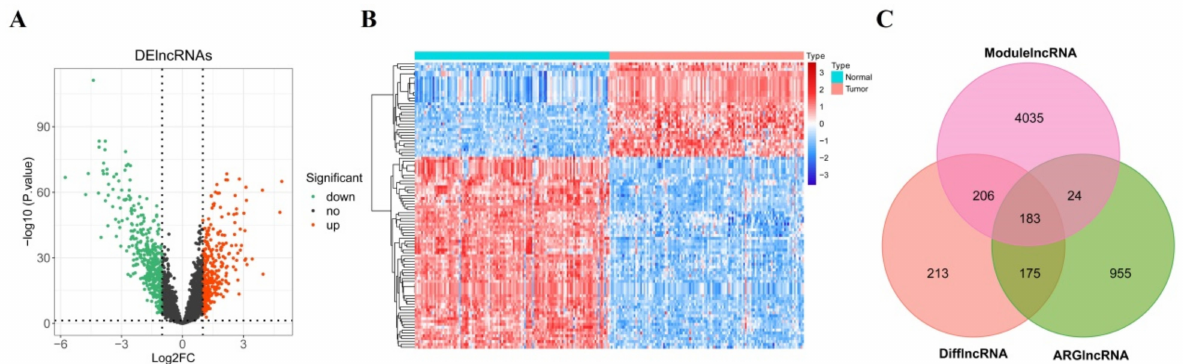
Figure 2. Screening the prognostic DEARlncRNAs in ESCC patients; ( A ) Volcano plot visualized the differential expression genes between ESCC and normal samples. The upregulated gene is displayed in red dot and the downregulated gene is in green; ( B ) The heat map of the top 100 DElncRNAs. The row and column represent genes and samples, respectively; ( C ) Venn plots reveal the overlapping